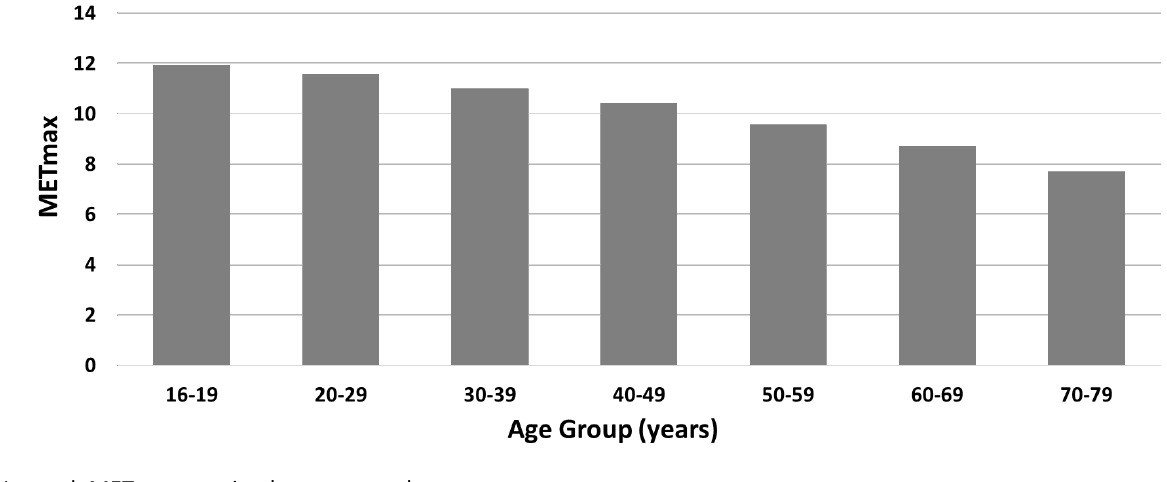
Legend: METmax=maximal oxygen